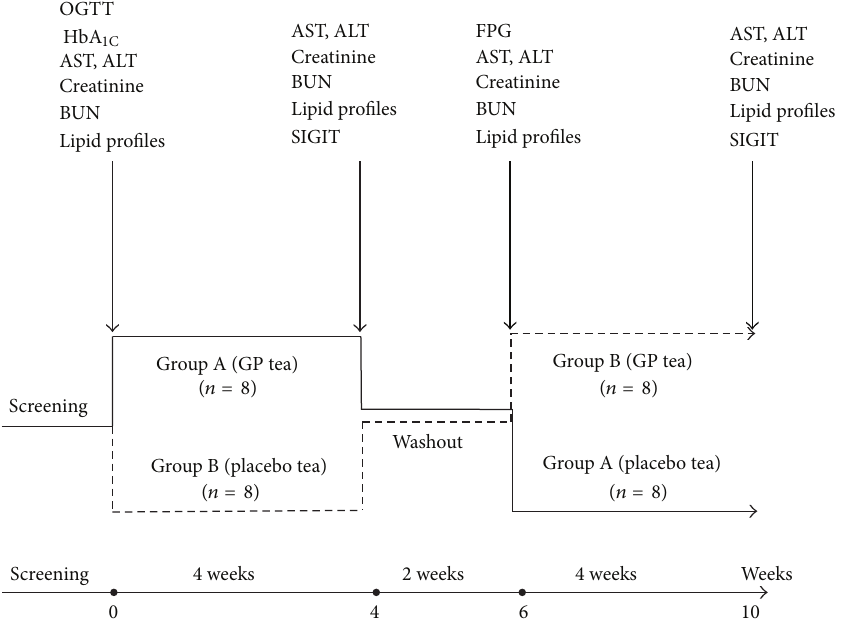
Figure 1: Study protocol. Lipid, kidney, and liver function tests were performed at week 0, 4, 6, and 10. Fasting plasma glucose and insulin were determined every second week. OGTTs (oral glucose tolerance tests) and HbA 1 insulin-glucose infusion test) was performed at the end of each treatment